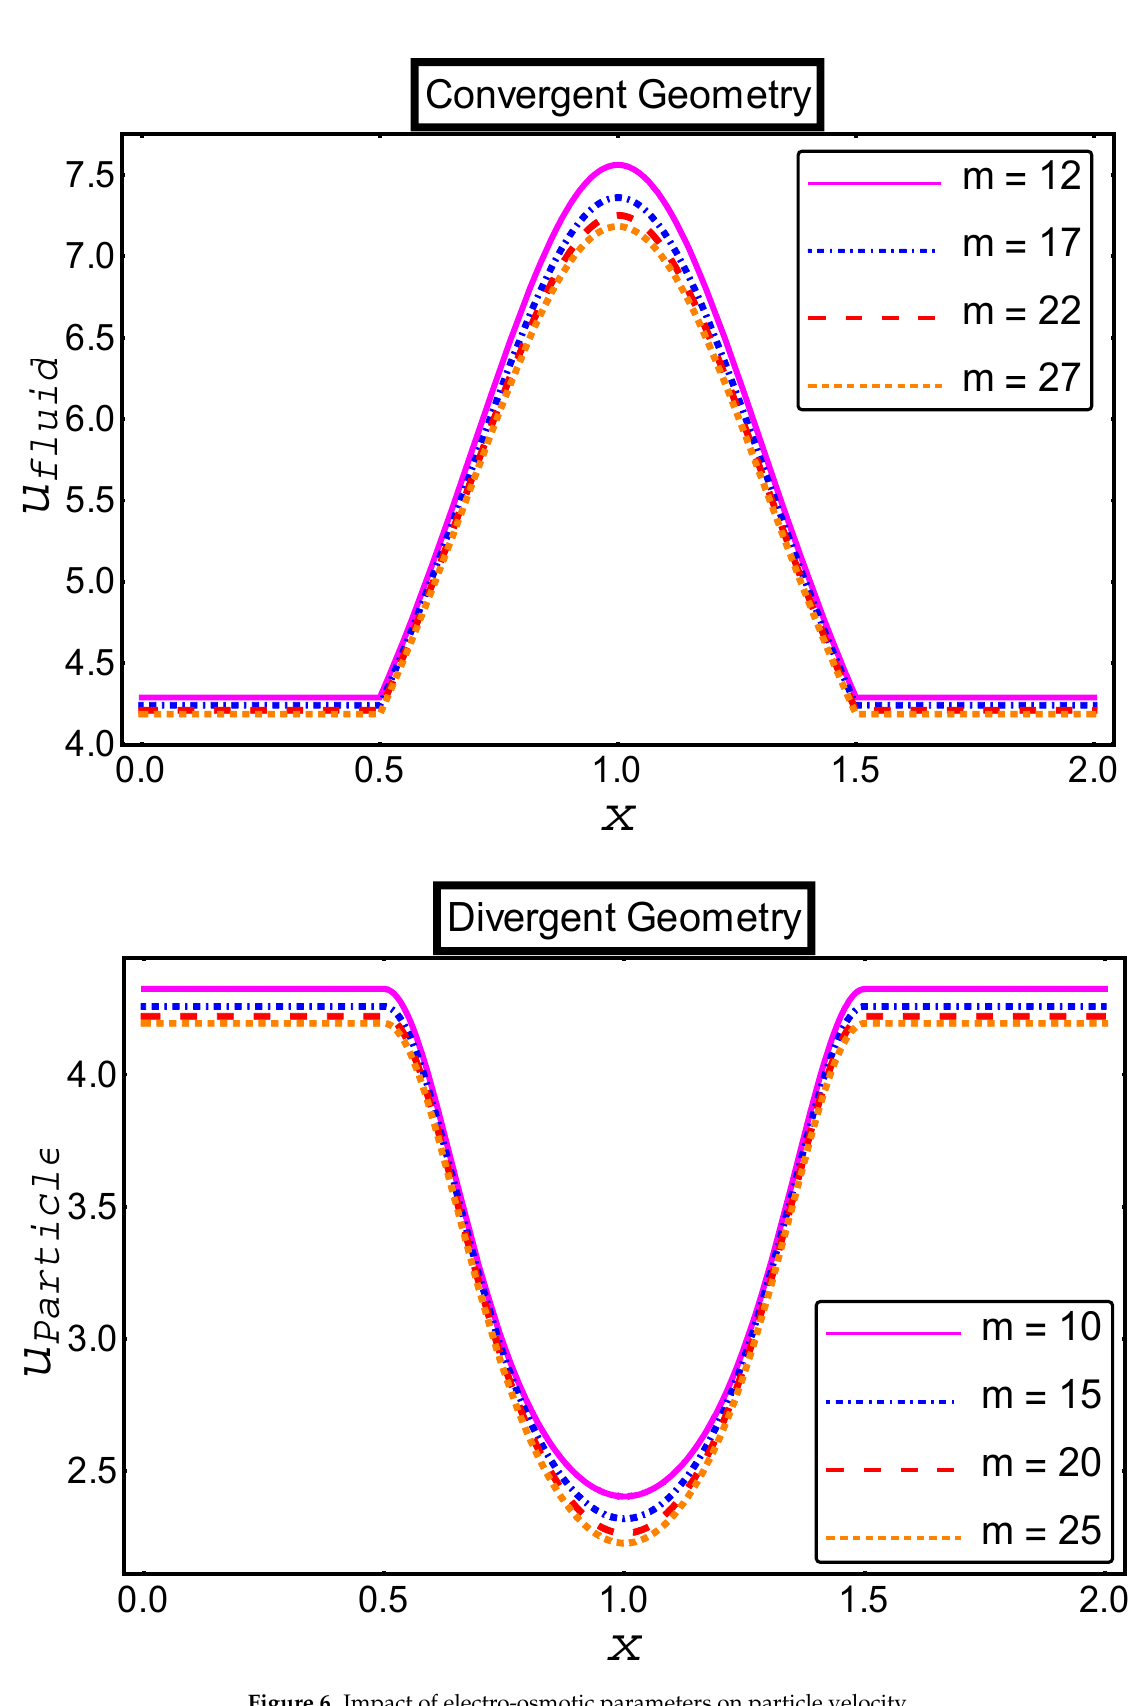
Figure 6. Impact of electro-osmotic parameters on particle velocity.